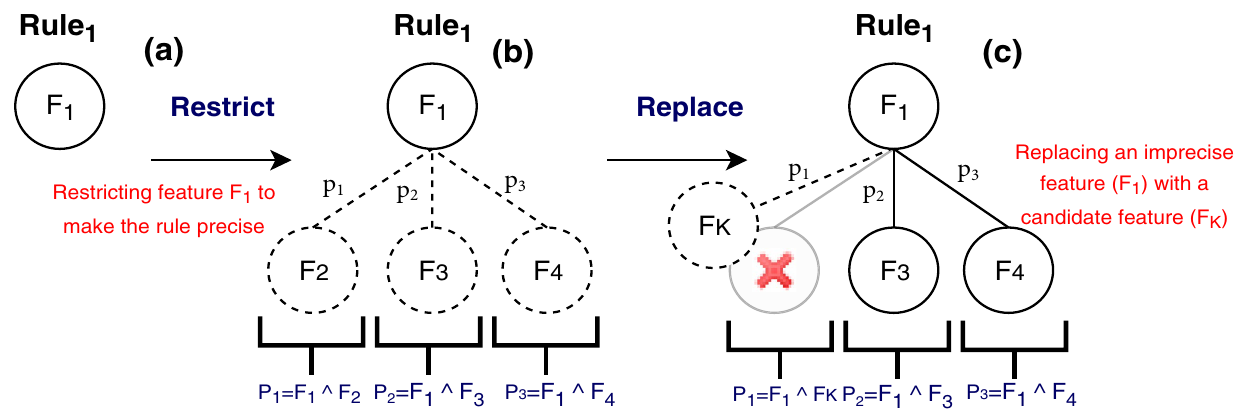
Fig. 3 Adapting a rule by replacing/restricting its